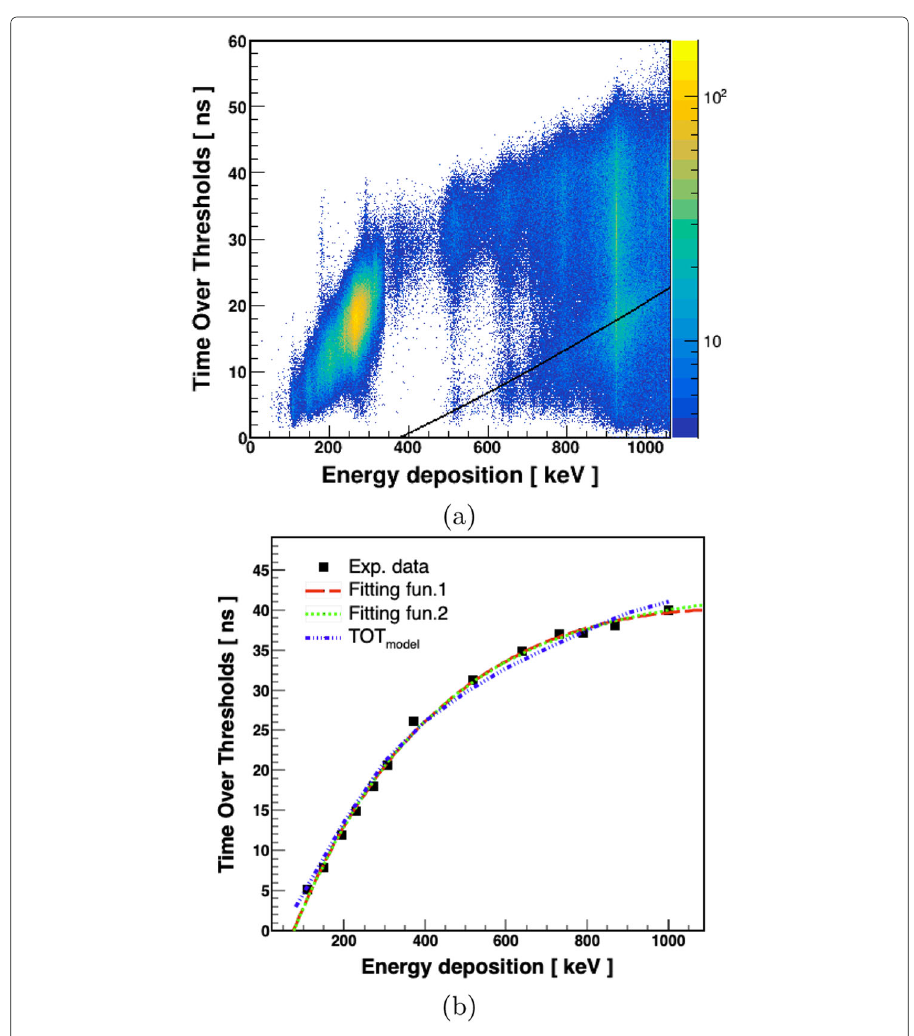
Fig. 11 a 2-D spectrum of TOT versus energy deposition. b TOT vs energy deposition. Black rectangles correspond to the experimental data. The statistical errors in measuring the values are smaller than the size of symbols due to the large number of entries for the fitted TOT distributions. The red dashed line indicates result of the fit of the function: TOT = A0 + A1 * ln(E dep + A2) + A3 * (ln(E dep + A2)) 2 , with A0 = -2322 ns, A1 = 632.1 ns/keV, A2 = 590.2 keV, and A3 = -42.29 ns/(keV) 2 . Green dotted line shows the result of another fitting function TOT = A0 ns - A1 * A2 E dep with three parameters where A0 = 42.96 ns, A1 = 53.43 ns, and A2 = 0.997 keV − 1 . Blue dotted-dashed line represents the model predictions (the “Theoretical model” section) for the total TOT values at four fixed thresholds for the time distribution spectra calculated by using Eq. 3. In framework of J-PET, the light signals are collected on both sides of plastic scintillator as a measure of energy deposition, so in calculating the TOT model , we used twice the value of TOT sum and the value of free parameter N 0 is